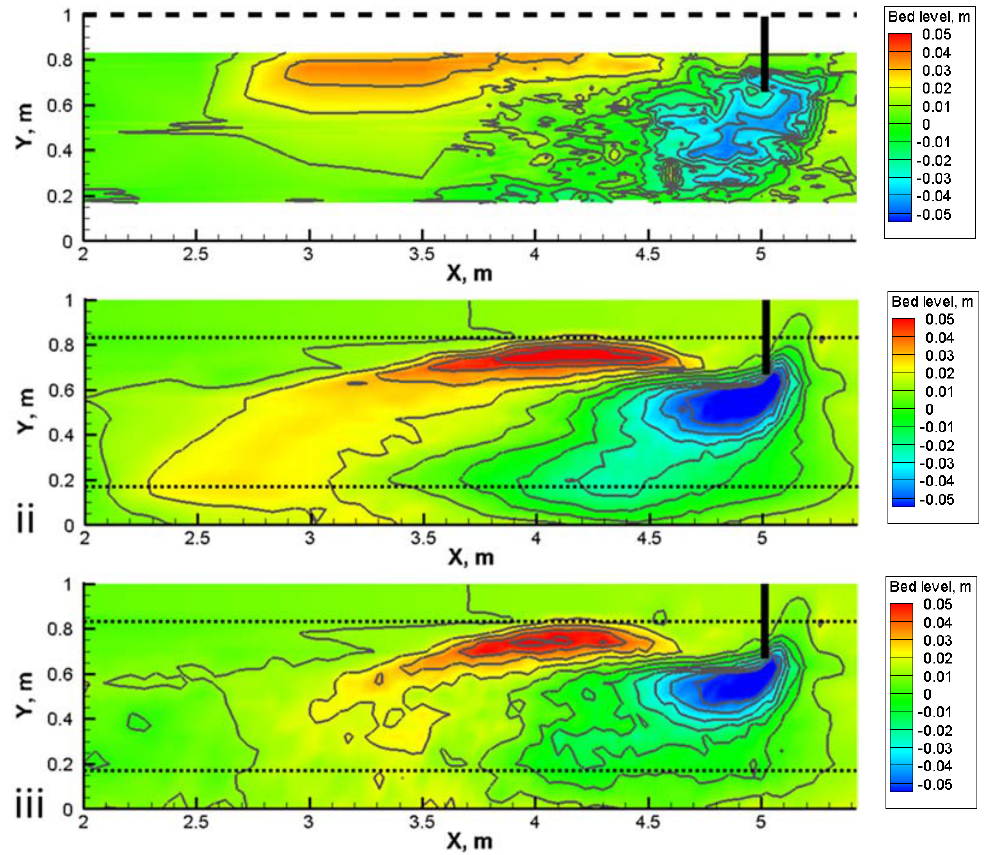
Figure 11. Measured and simulated equilibrium bed levels at Q = 72 L/s. (top: measured; ii: Wilcock and Crowe formula; iii: combined approach).